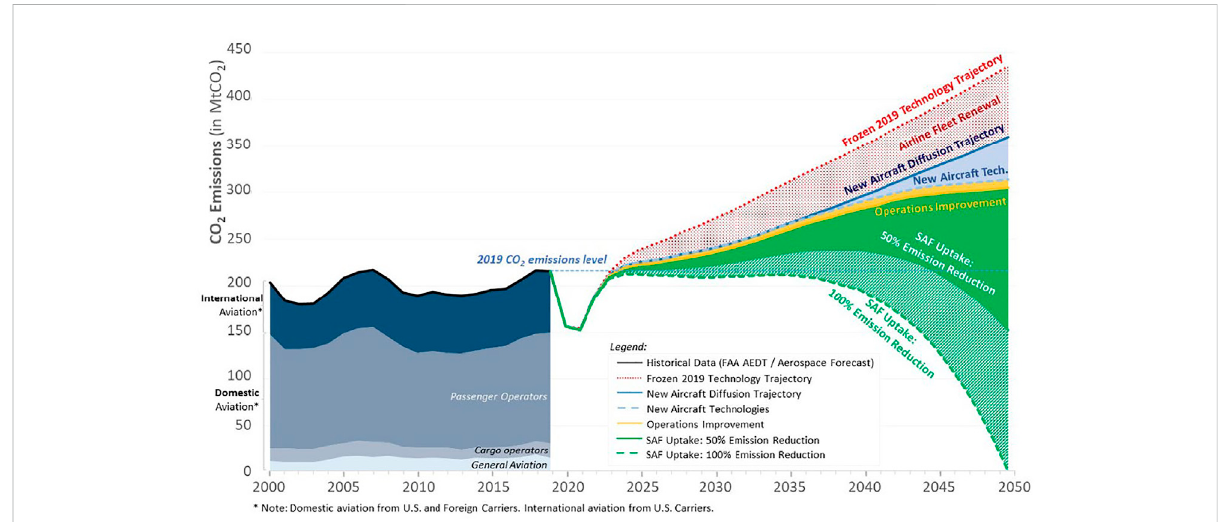
Projection of future annual emissions of aviation out to 2050 with and without the application of the “ basket of measures ” of operational and technologicaladvancementsandSAFdeployment.WithoutSAF,theaviationsectorwillnotmeetthenet-zeroemissions goalstheyhaveset.Source (United States, 2021) used with